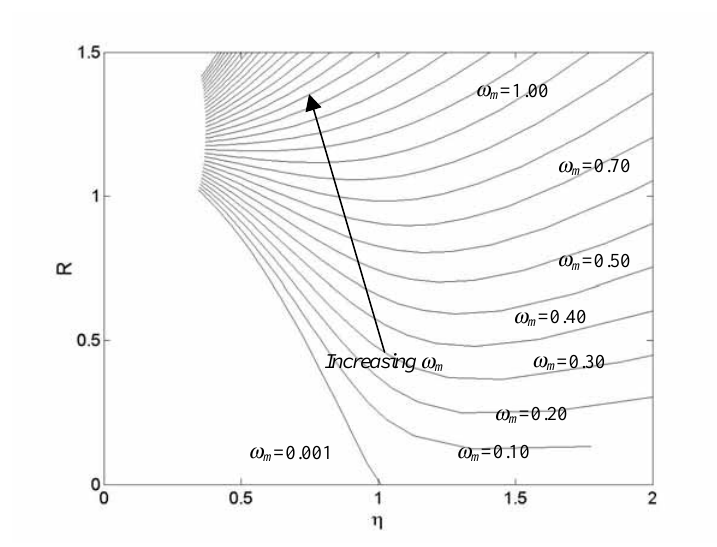
Fig. 18. Lines of constant stiffness with varying